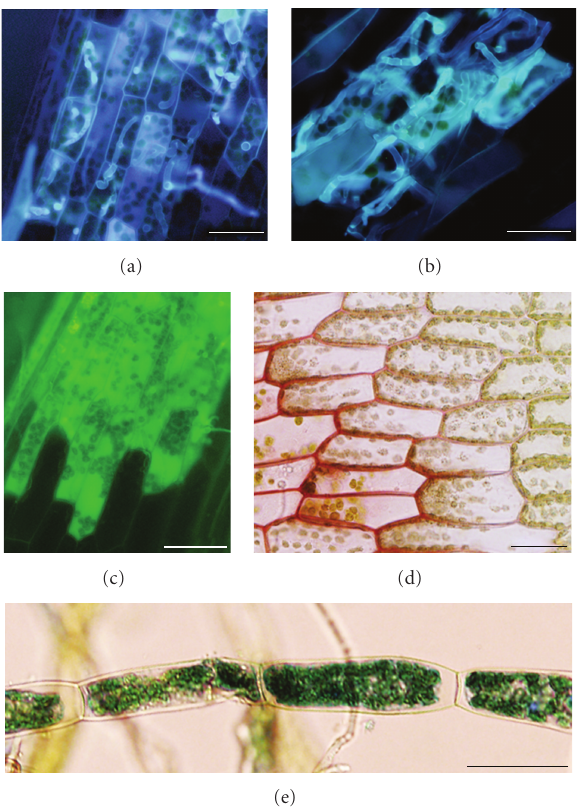
Figure 2: Pathogen growth and P. patens responses. P. irregulare - infected leaf (a) and B. cinerea -infected leaf (b) showing hyphal tissues stained with the fluorescent dye solophenyl flavine 7GFE 500, (c) ROS production in P. debaryanum -infected leaf stained with H 2 DCFDA, (d) Incorporation of phenolic compounds in cell walls of a P. irregulare -infected leaf visualized by safranin-O, (e) Evans blue staining of B. cinerea -inoculated protonemal filaments showing cytoplasmic shrinkage. The scale bar represents 20 μ